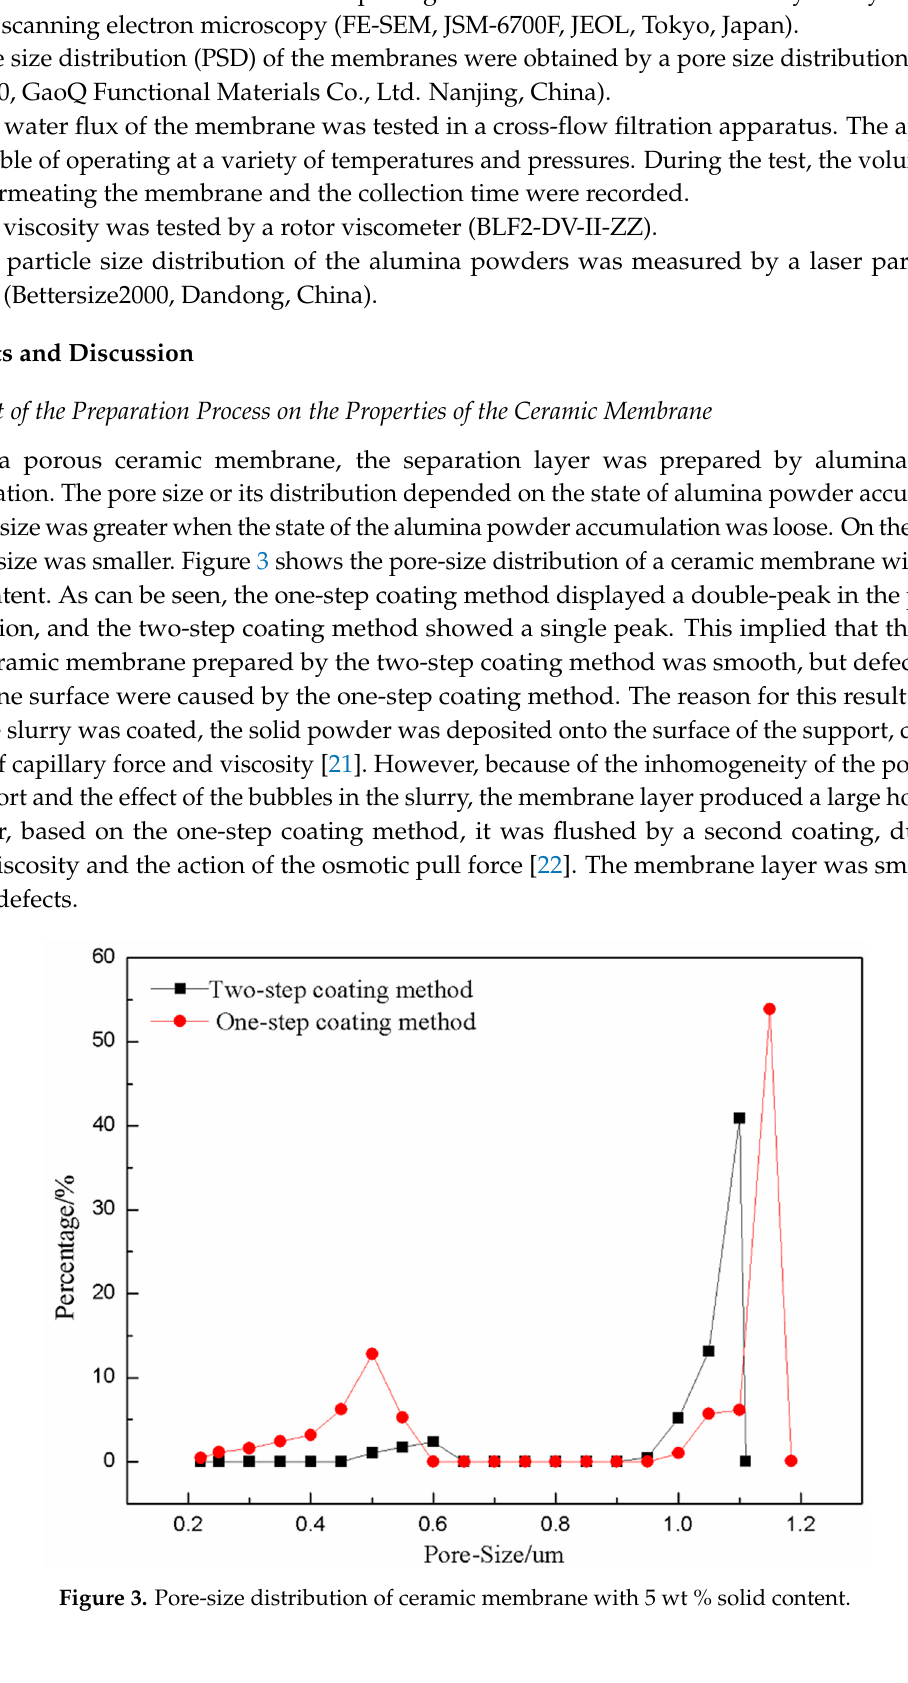
Figure 4. Schematic diagram of coating with different coating methods ( A : one-step coating; B : two- step coating). Figure 5. SEM images of the samples prepared by different coating methods. A —One-step coating method; B —Two-step coating method.